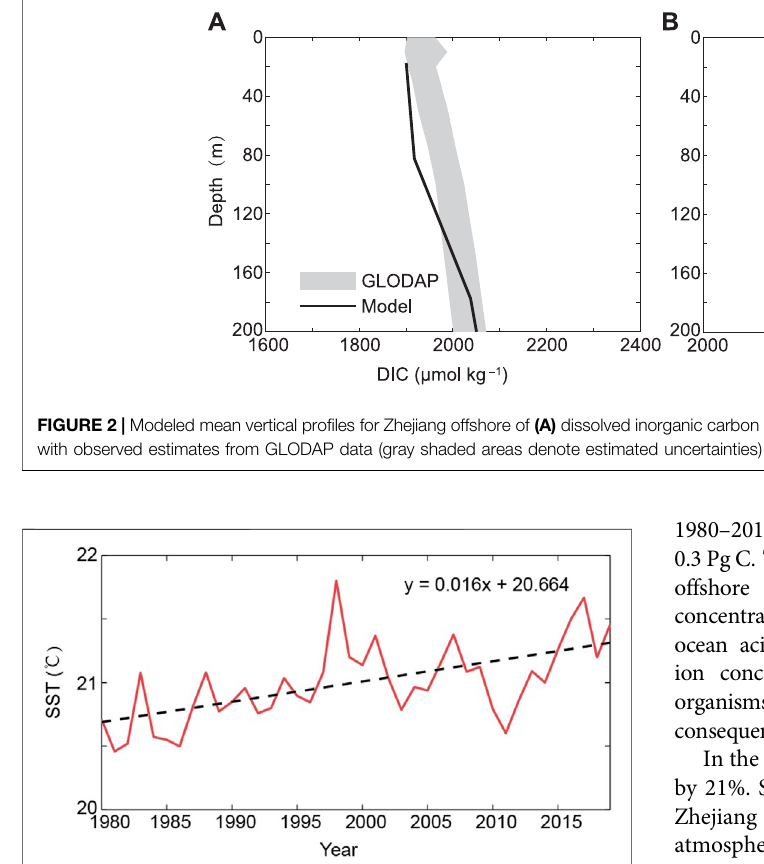
FIGURE 3 | Annual mean variation and linear trend of SST in Zhejiang offshore from 1980 to 2019.